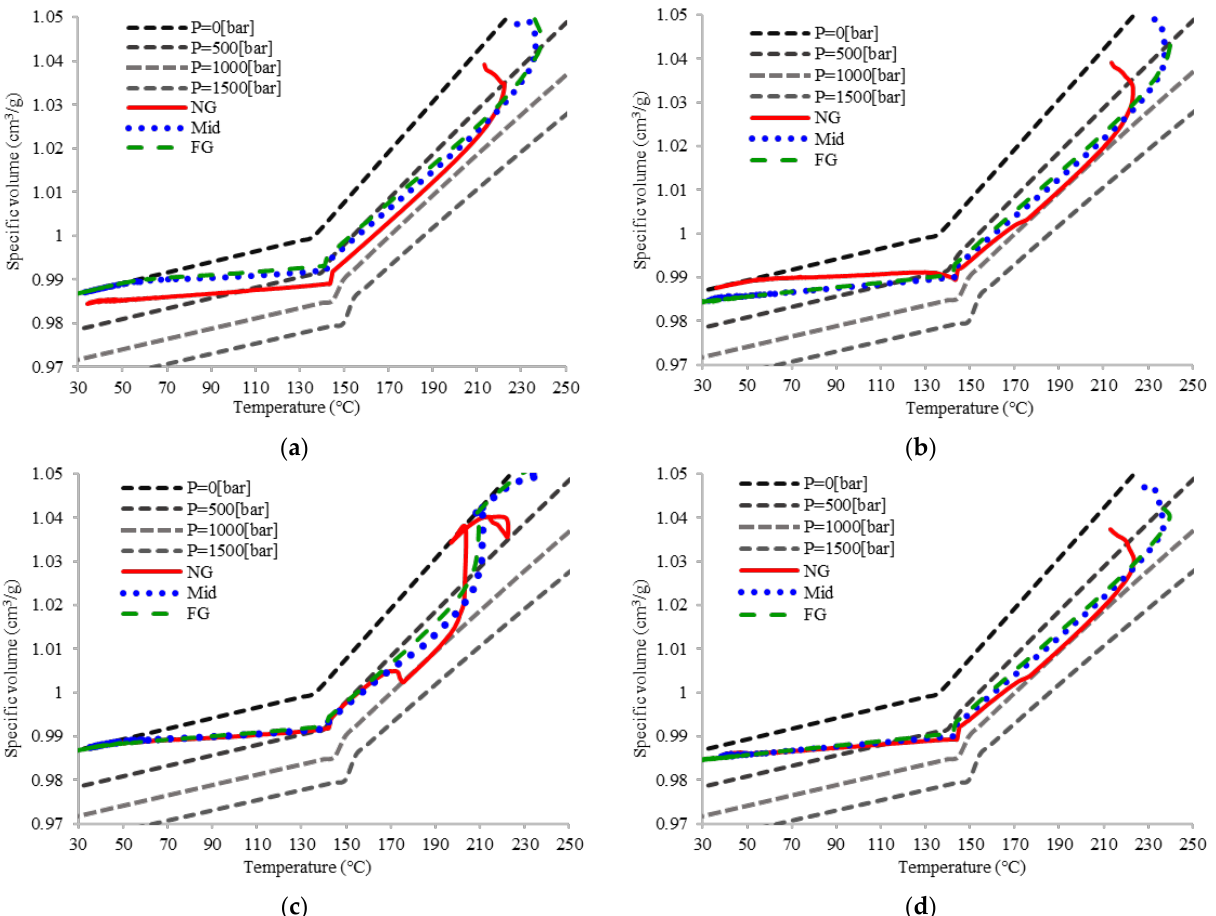
Figure 14. PVT processing paths for ( a ) single packing, ( b ) sequential packing setup, ( c ) intermittent packing setup, and ( d ) dynamic packing technique.